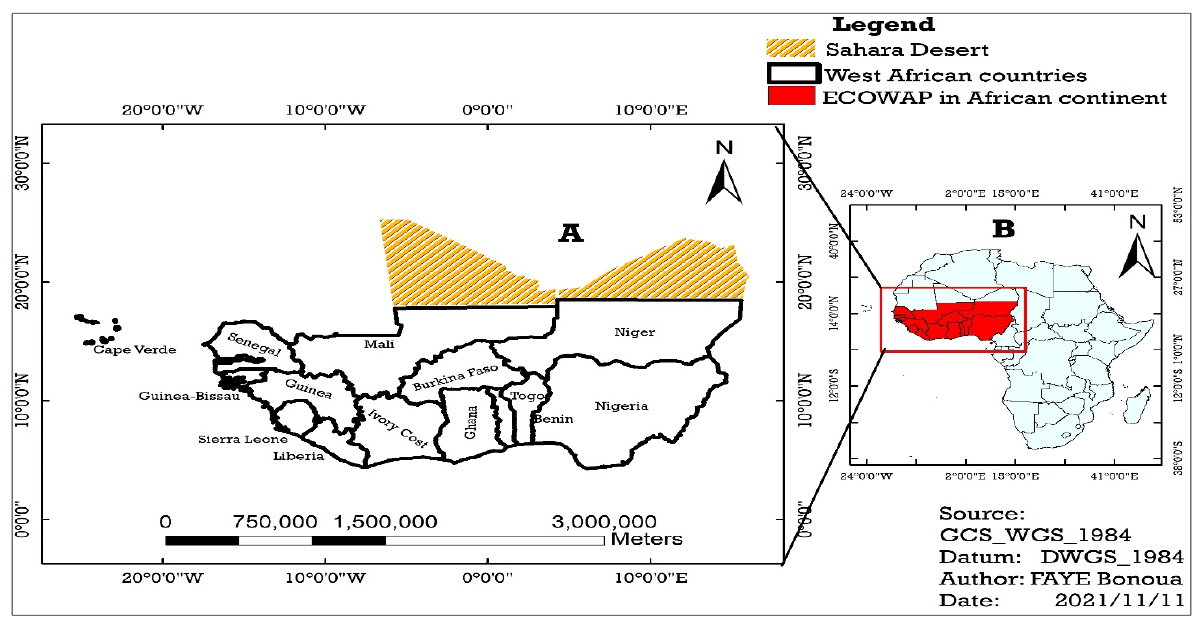
Figure 1. The geographical location of the study area: ( A ) represents the localization of the study area with 15 countries; ( B ) represents the African continent’s study area. Table 1. Socioeconomic statistical characteristics of the study area for 2019 (World Bank, 2021).